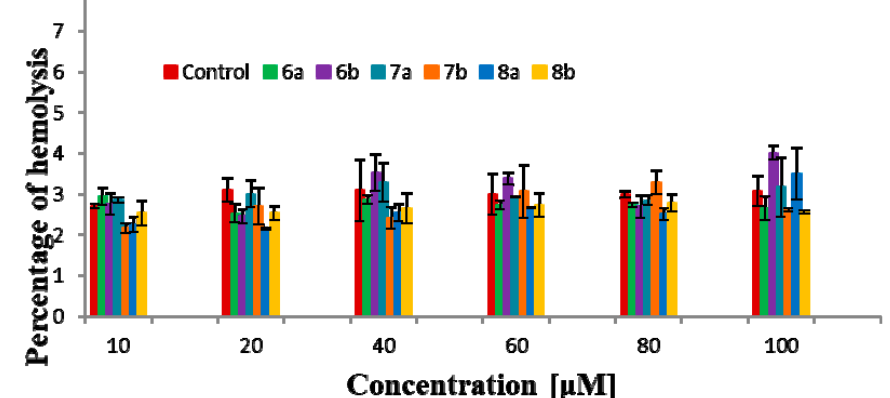
Figure 1. Hemolysis of RBCs dependent on concentration of compounds.